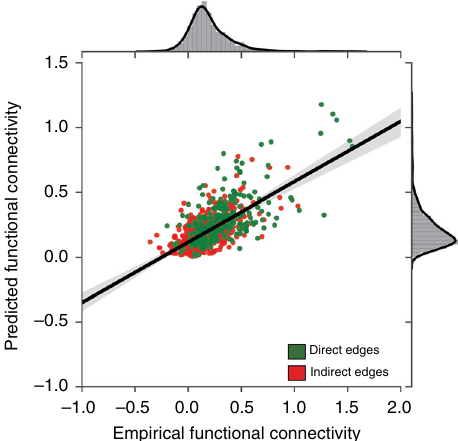
Fig. 5 Prediction of resting state functional connectivity from structural embbedings using deep learning. Green and red dots mark direct and indirect edges respectively. A signi fi cant correlation between the empirical functional connections and the predicted functional connections is apparent when all connections are taken into account ( r s = 0.6, p < 10 − 6 ), as well within the direct ( r s = 0.6, p < 10 − 6 ) and indirect connections separately ( r s